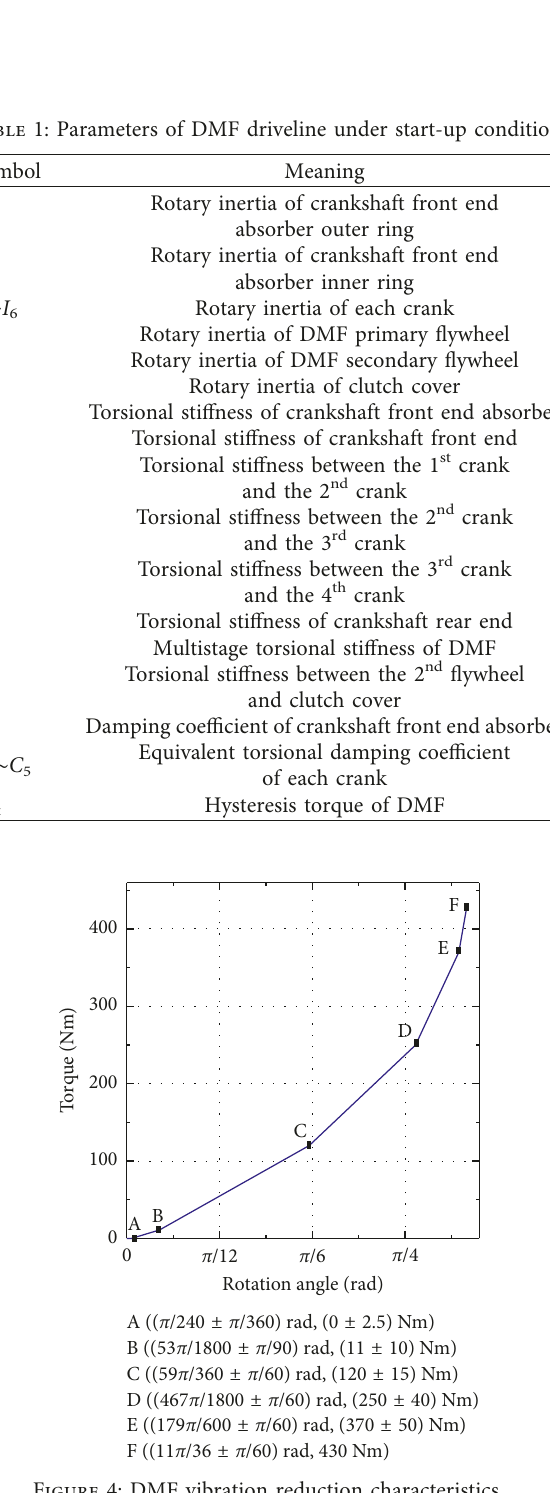
Figure 4: DMF vibration reduction